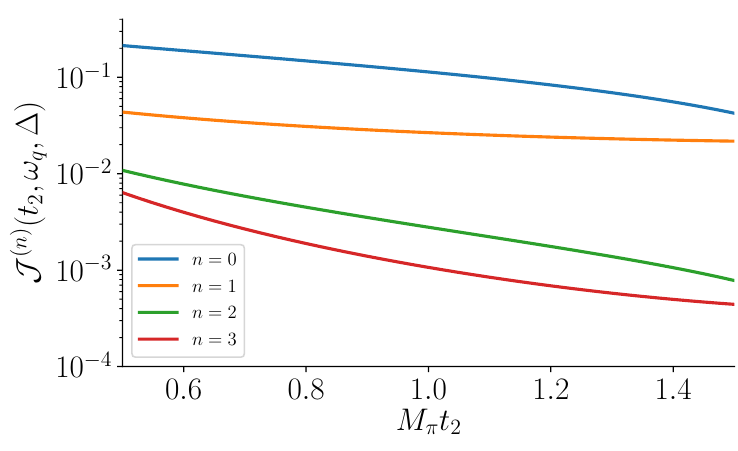
Figure 3 . Plot of the first few J ( n ) ( t 2 , ω q , ∆) functions, defined in eq. (2.42) of the main text, vs t 2 with ω q = 3 m π and ∆ = m π